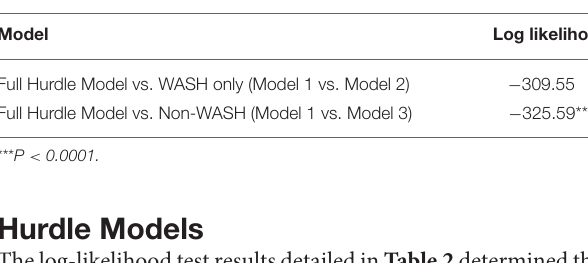
TABLE 2 | The log-likelihood test results between full Hurdle Model vs. Water, Sanitation, and Hygiene (WASH) only (model 1 vs. model 2) or vs. Non-WASH (model 1 vs. model